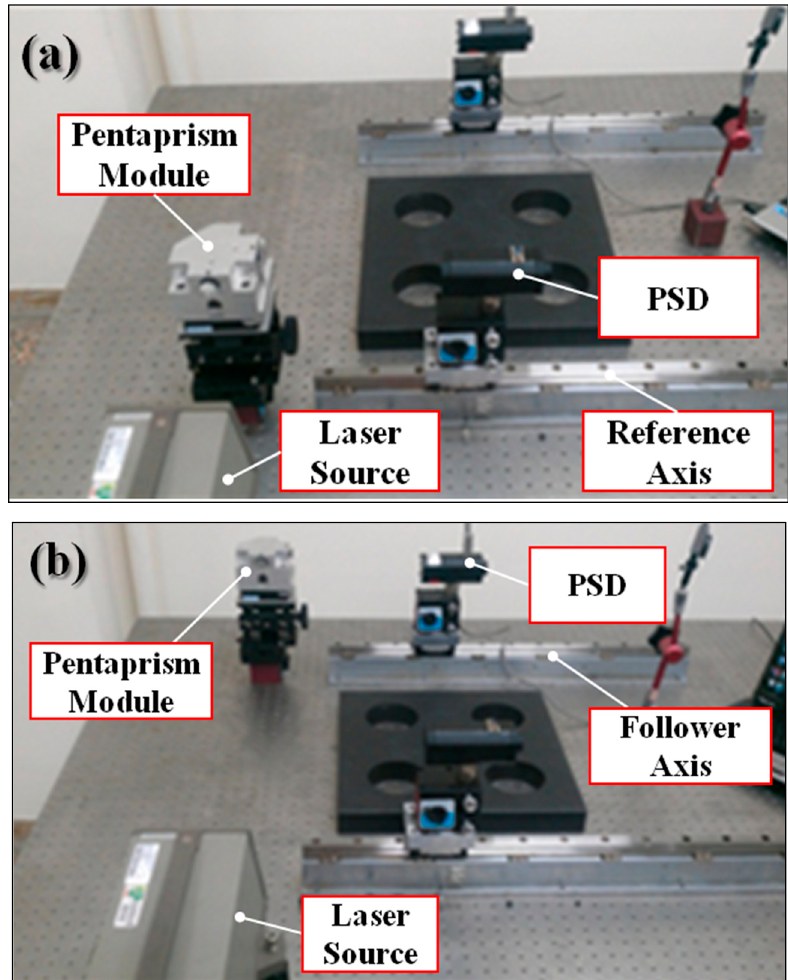
Figure 18. Verification setup of parallelism measurement using a square block.